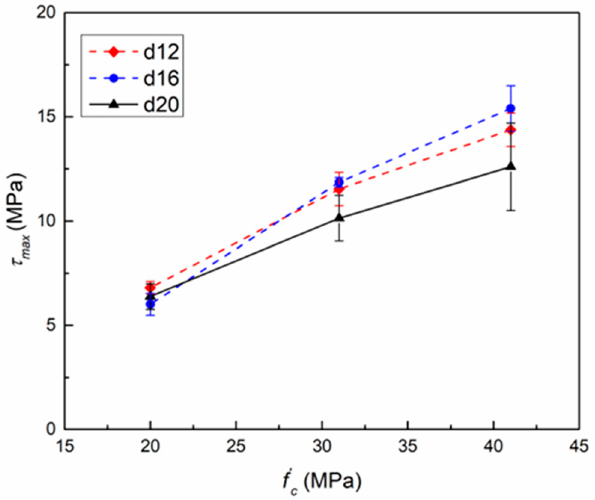
Figure 7. Relationship between compressive strength and bond strength with three types of reinforcing bars.